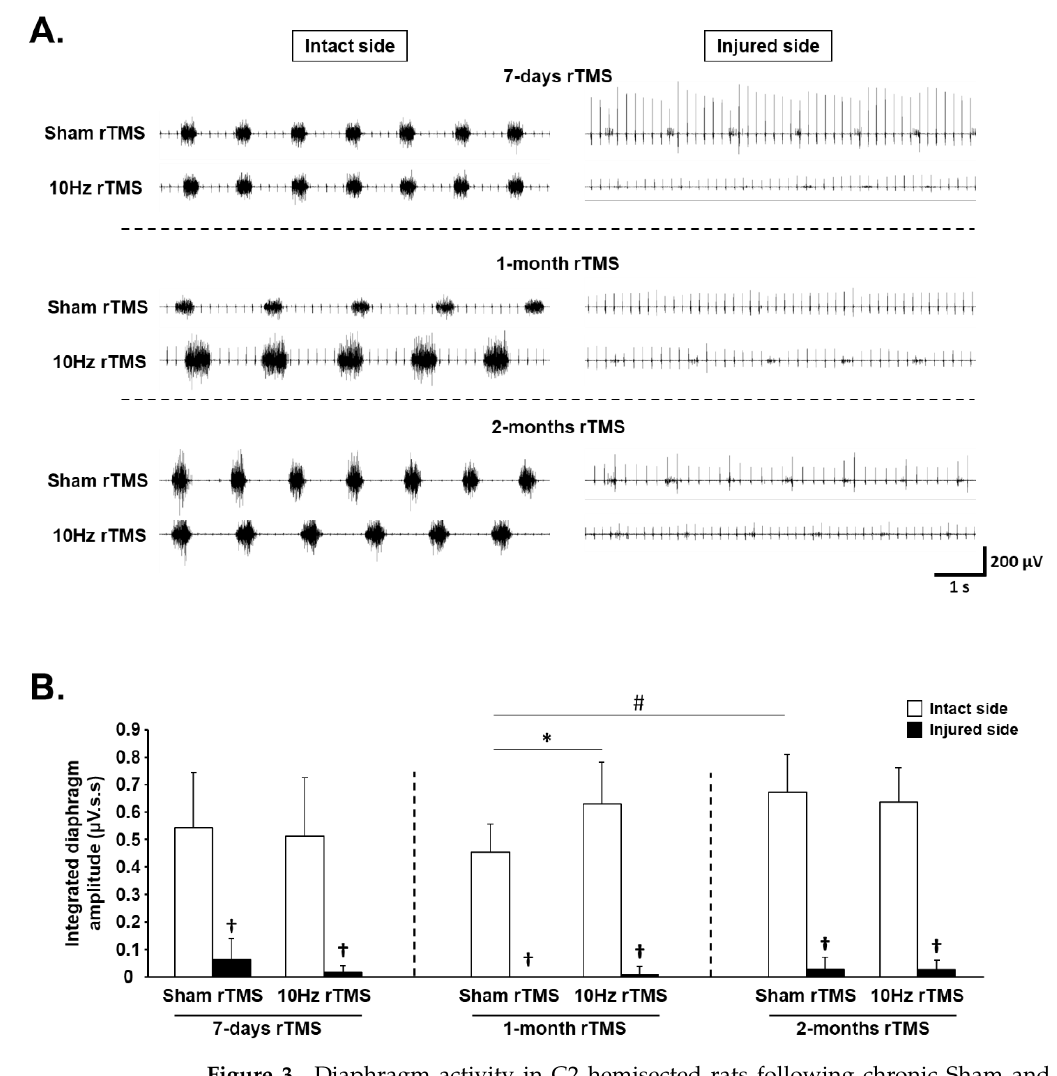
Figure 3. Diaphragm activity in C2 hemisected rats following chronic Sham and 10 Hz rTMS: ( A ) representative traces of raw diaphragm EMG of C2 hemisected rats, following 7-day, 1-month, or 2-month Sham or 10 Hz rTMS treatment; ( B ) integrated diaphragm amplitude for intact and injured sides of Sham or 10 Hz rTMS treated C2 hemisected animals following 7 days, 1 month, or 2 months of treatment. † p < 0.001, compared with intact side; * p = 0.011, intact side of Sham rTMS group vs. intact side of 10 Hz rTMS group following 1-month treatment. # p = 0.039, intact side of Sham rTMS group following 1-month treatment vs. corresponding group following 2 months of